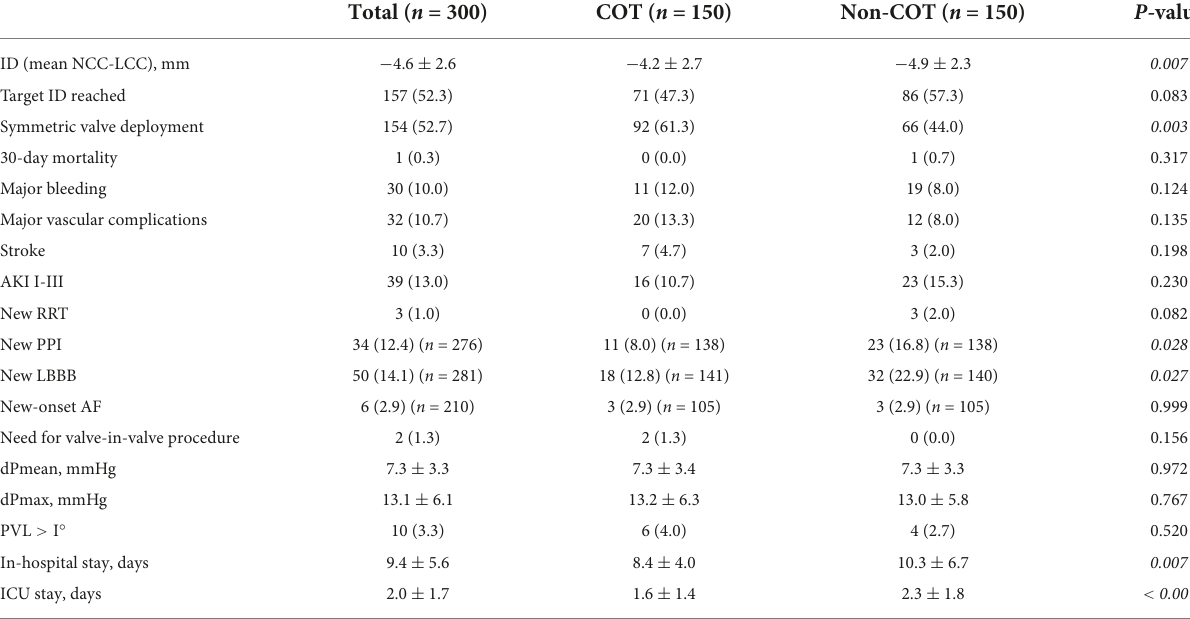
TABLE 4 A total of 30-day procedural outcome in matched